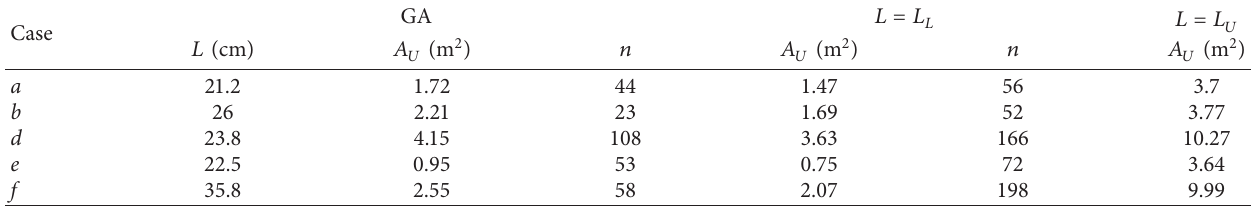
Figure 5: Sample of test scenarios taken as obstacle clusters. In each case, the first figure depicts the footprint layer, the red-colored grid represents the optimum cell size generated for P-hTetro, and the grid resulting for the robot with fixed size L L is depicted in blue. (a) A segment of a bedroom. (b) and (c) A couch at a lobby or a living area. (d) Meeting room. (e) The seating arrangement of a waiting area. Table 1: Sample results for comparison of area coverage and coverage